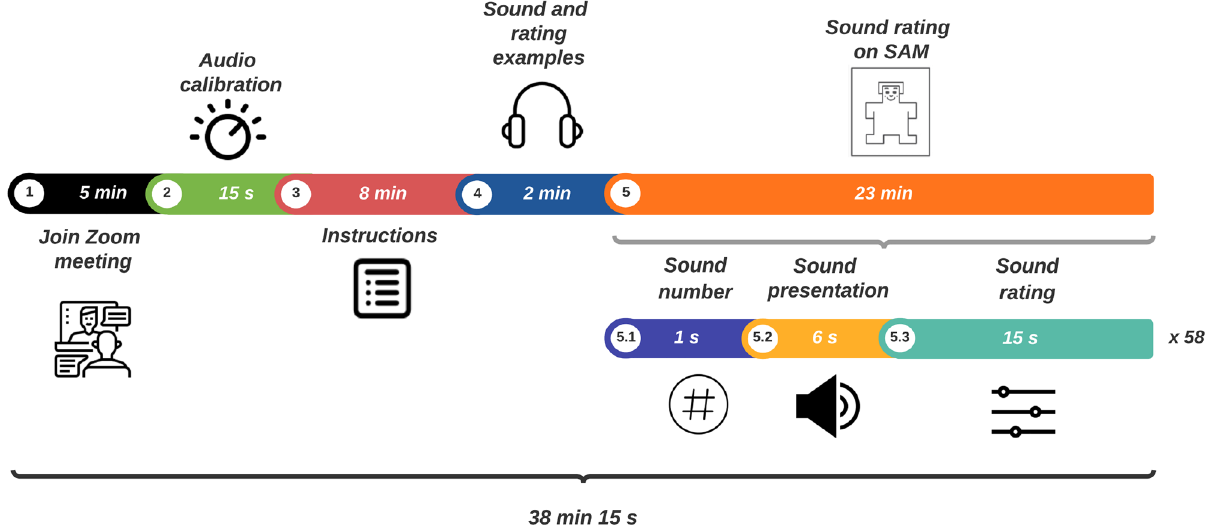
Figure 1. Experimental design: from joining virtual meeting to SAM. Participants joined a Zoom online meeting.